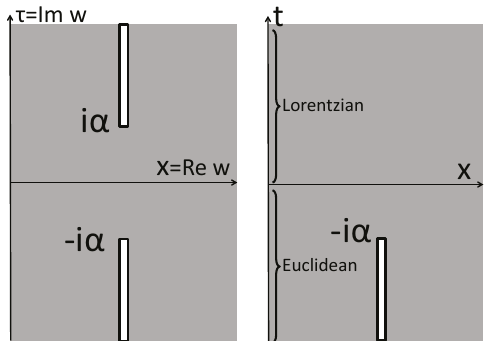
Figure 15 . The geometries which realize the joining local quenches. The left (cid:12)gure describes the space on which we perform the Euclidean path-integral. This is mapped into an upper half plane by the map (5.1). The right picture describes the path-integral realization of the time evolution after the joining process happened at t = 0, where the Euclidean path-integral for (cid:28) < 0 creates the state just after this